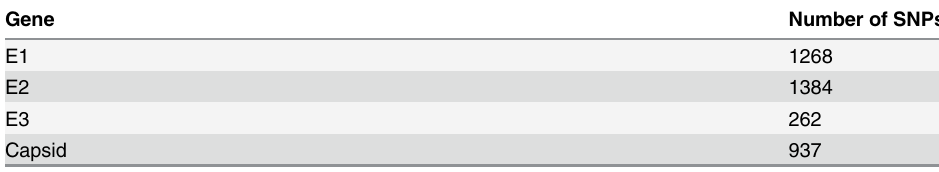
Table 2. Numbers of SNPs identified in VEEV genomes, by gene